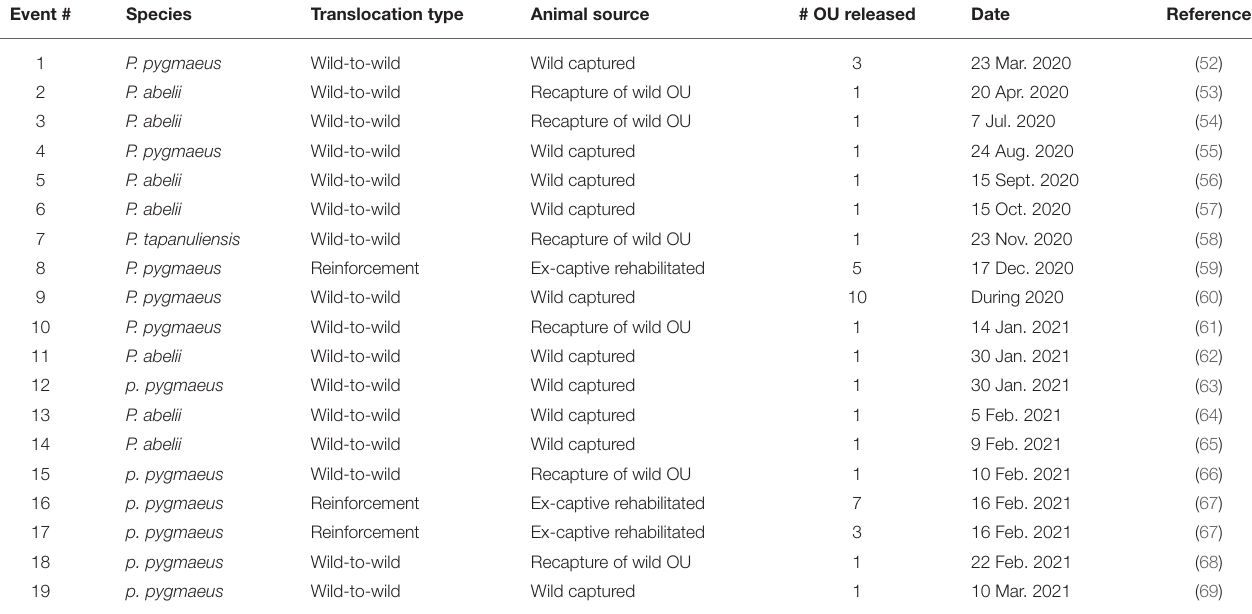
TABLE 3 | Orangutan translocations during the COVID-19 pandemic in Indonesia. Event